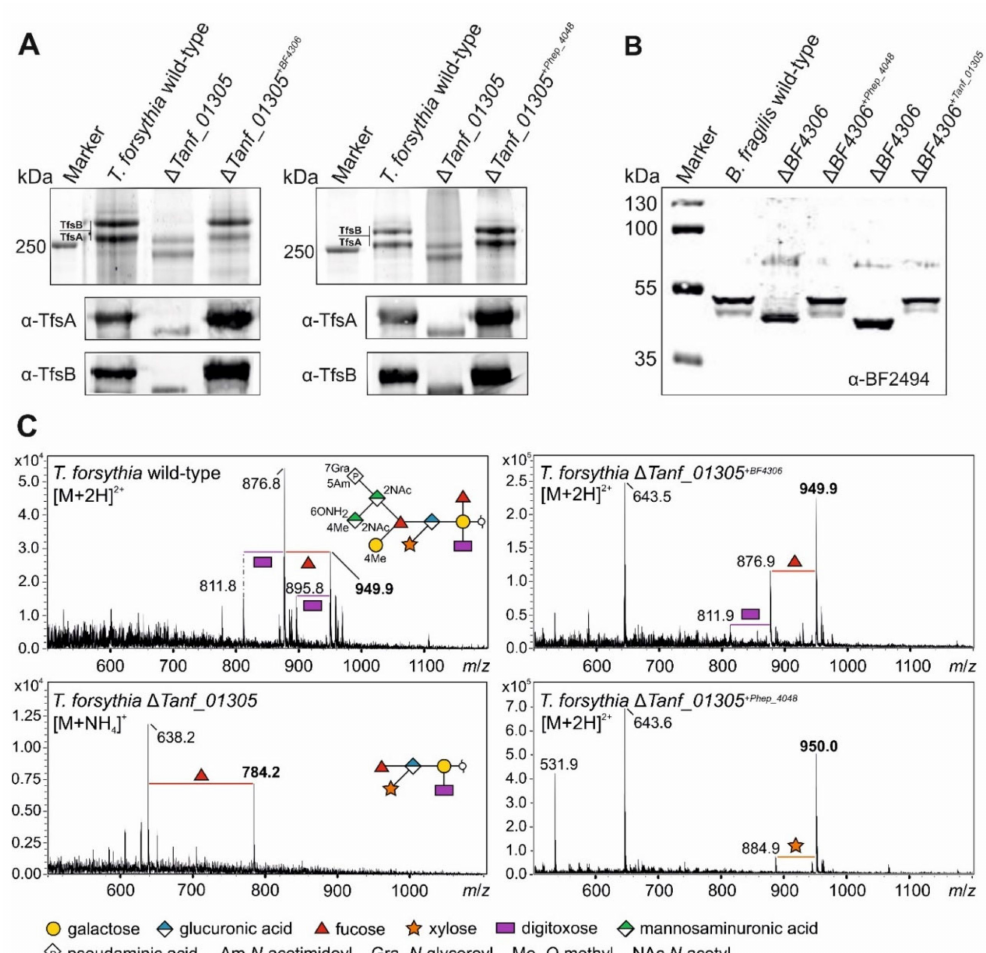
Figure 9. ( A ) Analysis of crude cell extracts from T. forsythia ATCC 43037 wild-type, the FucT-deficient mutant ( ∆ Tanf_01305 ) and cross-complemented strains ( ∆ Tanf_01305 + BF4306 ; ∆ Tanf_01305 + Phep_4048 ) after separation on 7.5% SDS-PAGE gels. Top panels—CBB staining of the S-layer glycoproteins (labeled TfsA and TfsB) showing the downshifts resulting from glycan truncation in the mutant. S-layer glycoprotein bands were further processed for MS analyses. Bottom panels—same samples processed for Western immunoblot analysis probed with a α -TfsA and α -TfsB antiserum, respectively. PageRuler Plus Prestained Protein Ladder (Thermo Fisher Scientific) was used as a protein molecular weight marker. ( B ) Western immunoblot analyses of crude cell extracts from B. fragilis wild-type, the FucT-deficient mutant ( ∆ BF4306 ) and cross- complemented strains ( ∆ BF4306 + Phep_4048 ; ∆ BF4306 + Tanf_01305 ) probed with α -BF2494 antiserum. ( C ) ESI-MS sum spectra of β -eliminated TfsB O -glycans from T. forsythia wild-type, ∆ Tanf_01305 and cross-complemented strains. The glycan structures of the signals corresponding to the largest mass (bold m / z values) are drawn according to the symbol nomenclature of glycans SNFG [48]. O -glycan signals detected for the mutant and cross-complemented strains were assigned based on the m / z mass differences corresponding to the loss of individual sugar units and/or modifications. Peak intensities are shown on the y